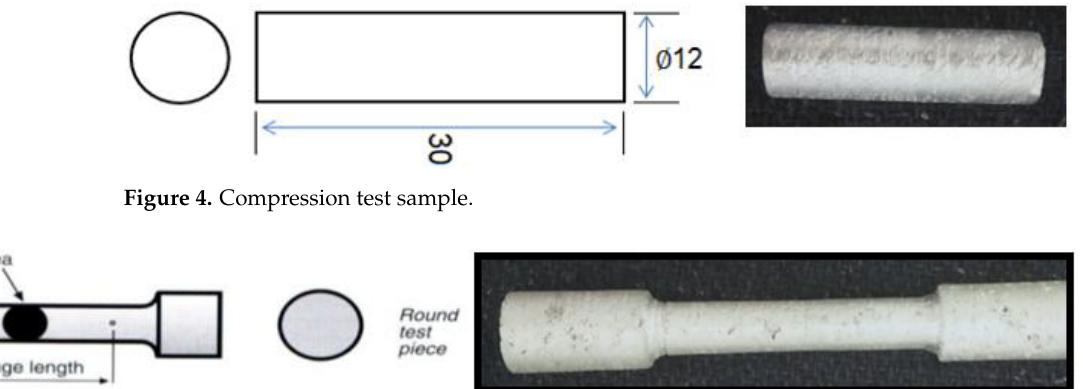
Figure 3. Hydraulic hot press machine.